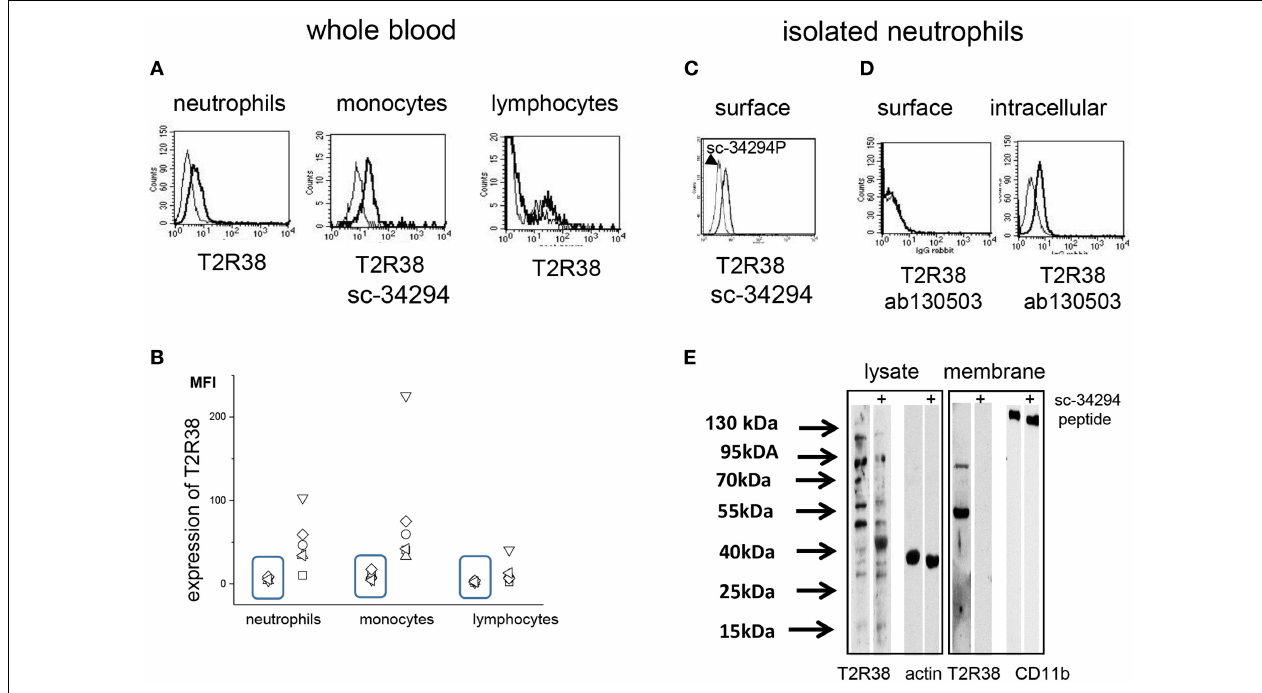
FIGURE 1 | Expression of T2R38 on peripheral blood cells . (A) Cytofluorometry using the antibody sc-34294 (thick line) showed expression of T2R38 [the gates were set according to the cell populations identified by expression of CD66b (neutrophils), CD14 (monocytes), and CD3 (lymphocytes)]. For comparison goat IgG (thin line) was used. (B) T2R38 was determined by cytofluorometry on peripheral blood cells of seven individuals (each represented by a symbol) and mean fluorescence intensity (MFI) is shown. The rectangles contain the data for the antibody isotype binding. (C) T2R38 was also seen on isolated neutrophils (thick line) and binding of the antibody could be inhibited by the specific antigen peptide (thin line)